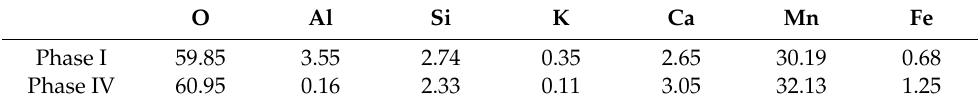
Table 3. Surface elemental composition (%) of the Fe–Mn co-oxide during phases I and IV.